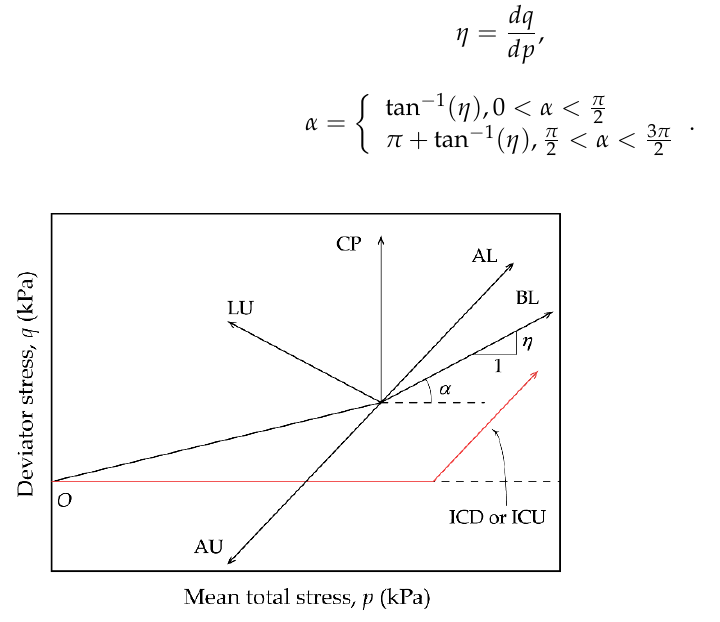
Figure 4. Various stress paths for triaxial tests conducted on the granite residual soil.